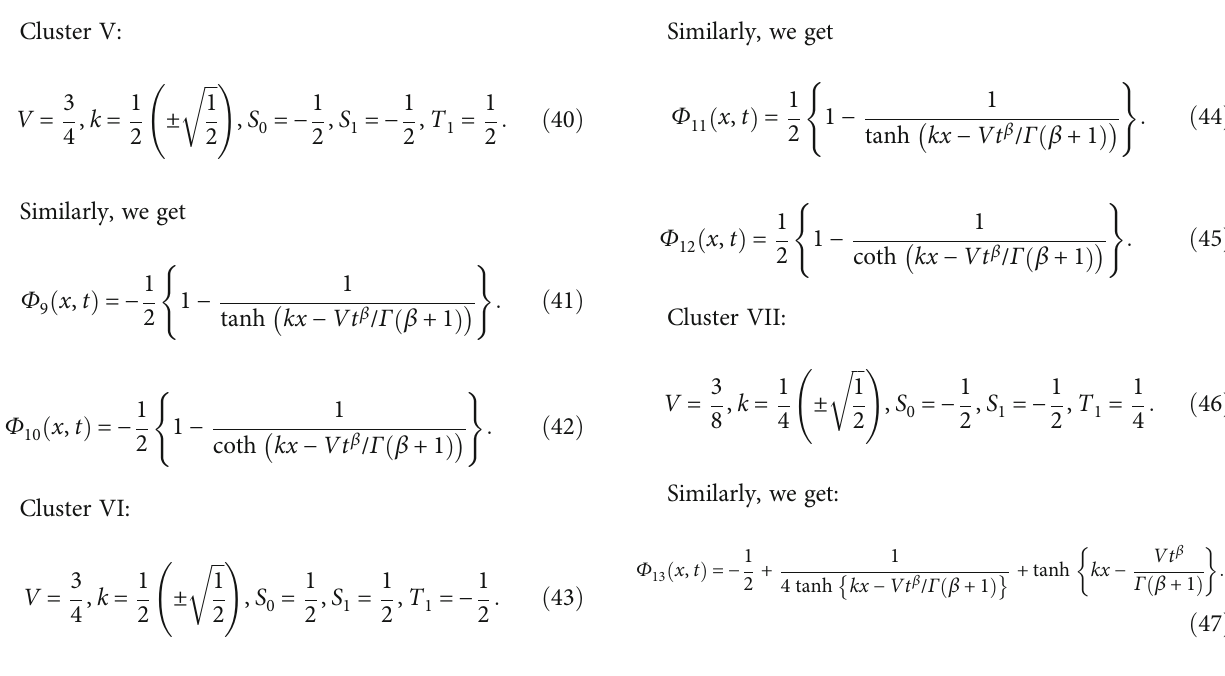
Figure 7: The graphical representation of the solution Φ real contour plot, and (d) imaginary contour